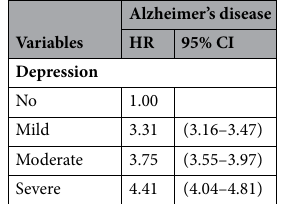
Table 4. Results of the association between depression and the risk of Alzheimer’s disease. The results were obtained after adjusting all the covariates included in the regression model in Table 2.